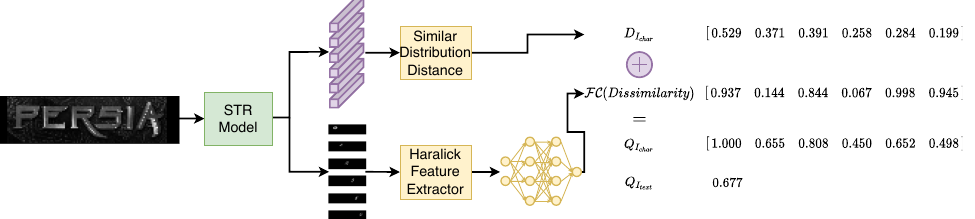
Figure 6. Predicting text image quality scores in the testing phase.